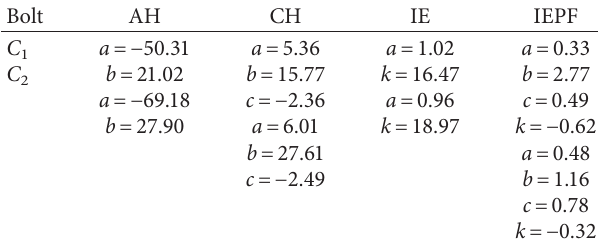
Figure 5: Comparison of each model with the test data from B